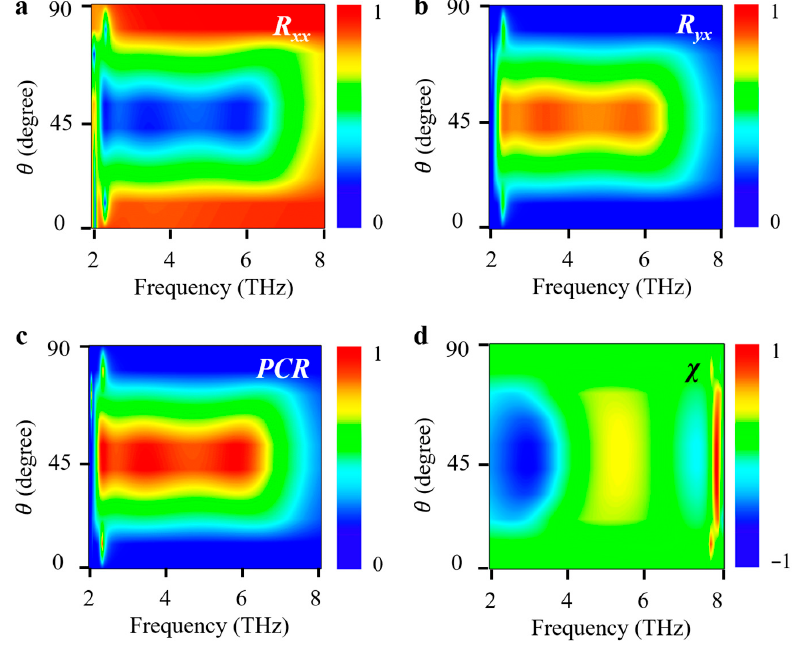
Figure 5. ( a , b ) The spectra of reflection coefficients for forward illumination of x -polarized lights for various rotation angles θ . ( c ) The calculated PCR ( x ) spectra and ( d ) ellipticity spectra of x -polarized lights for various rotation angles θ . VO 2 is in the metallic state.